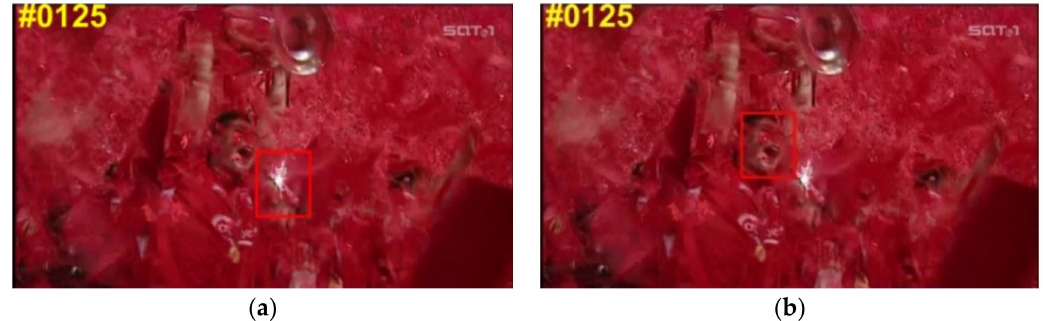
Figure 1. The tracking results of without model update strategy ( a ) and with the proposed model update strategy ( b ) in Soccer